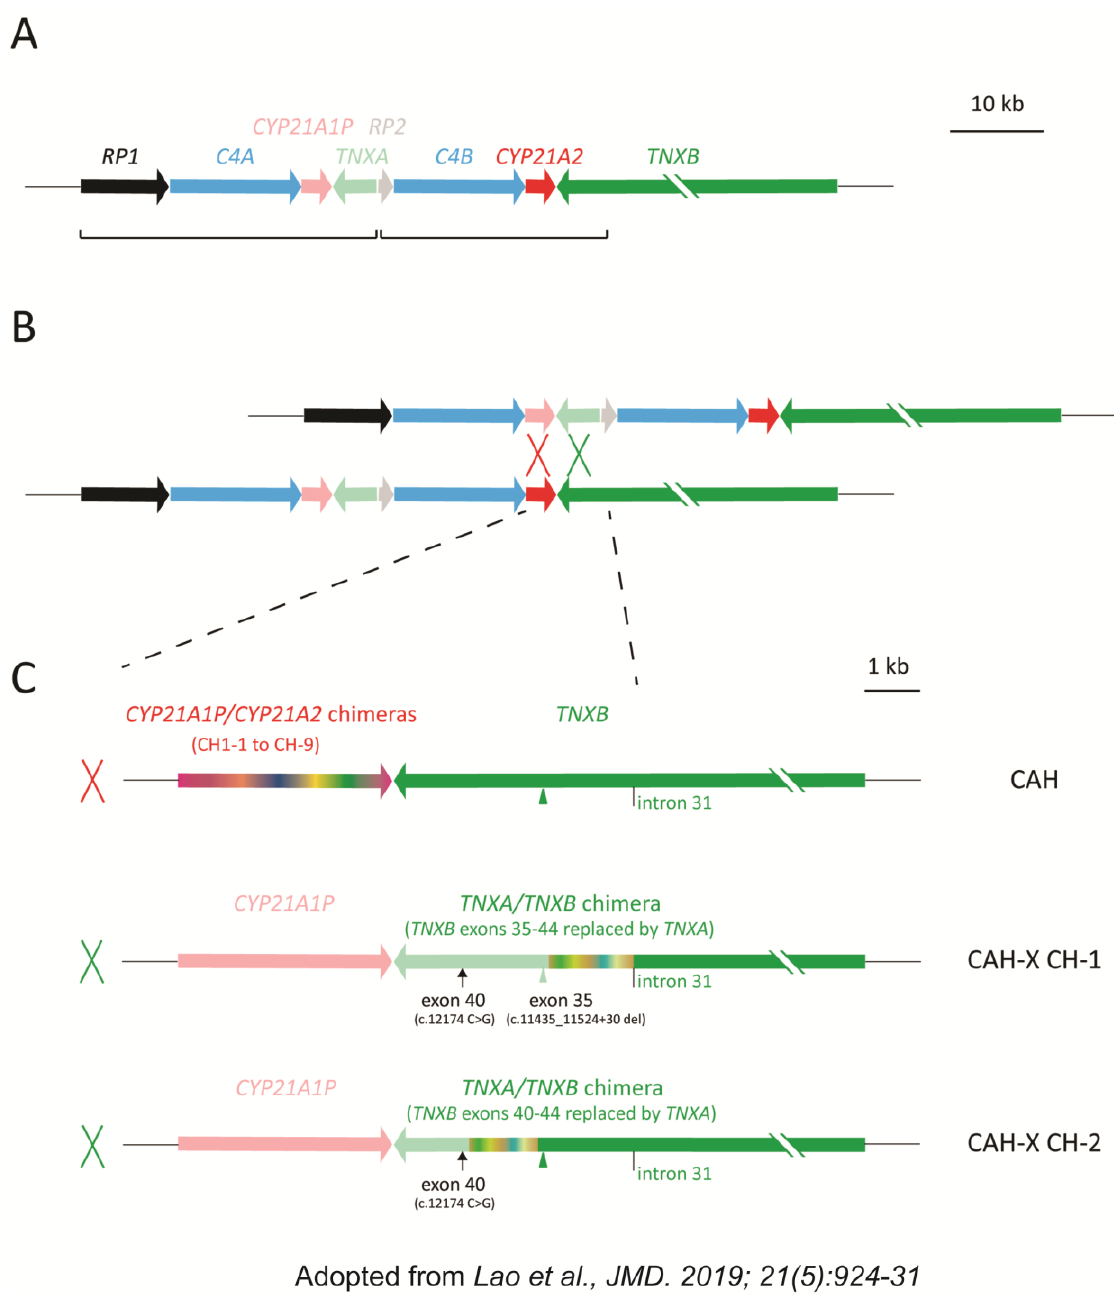
Figure 1. Schematic diagram of CAH and CAH-X chimeric genes [10]. ( A ), typical bimodular RCCX module: each pair of the homologous genes is shown in similar colors, with lighter colors representing pseudogenes; two RCCX units vulnerable for gene conversion are in brackets. ( B ), unequal crossover between CYP21A1P and CYP21A2 , or TNXA and TNXB , results in a commonly termed “30 -kb deletion” CAH genotype. ( C ), schemes of three major subtypes of “30 - kb deletion”: top, CYP21A1P/CYP21A2 chimeric genes with intact TNXB , pathogenic for CAH; middle, CYP21A1P- TNXA/TNXB chimera CAH-X CH-1 with TNXB exons 35 – 44 replaced by TNXA causes CAH-X due to tenascin-X haploinsufficiency; bottom, CYP21A1P-TNXA/TNXB chimera CAH-X CH-2 with TNXB exons 40 – 44 replaced by TNXA causes CAH-X due to a dominant negative effect. CAH-X CH-1 has an exon 35 c.11435_11524+30 deletion (light green triangle) and an exon 40 c.12174C>G mutation (small black arrow) in tandem, whereas CAH-X CH-2 has an intact exon 35 (green triangle) and an exon 40 c.12174C>G mutation. The junction site window for each chimeric gene is shown in chameleonic colors. Schemes from CYP21A1P to TNXB intron 31, which is the boundary of RCCX module homologous repeats, are shown in scale. The size of TNXB is 68 kb.